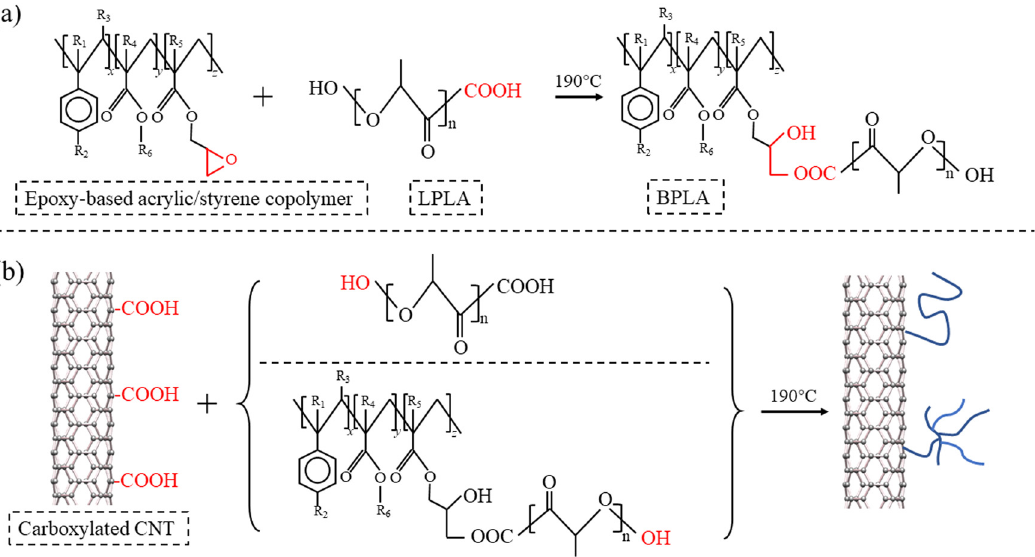
Figure 1: ( a ) Reaction between epoxy - based acrylic/styrene copolymer and LPLA chain, ( b ) reaction between caboxylated CNT, LPLA, and BPLA